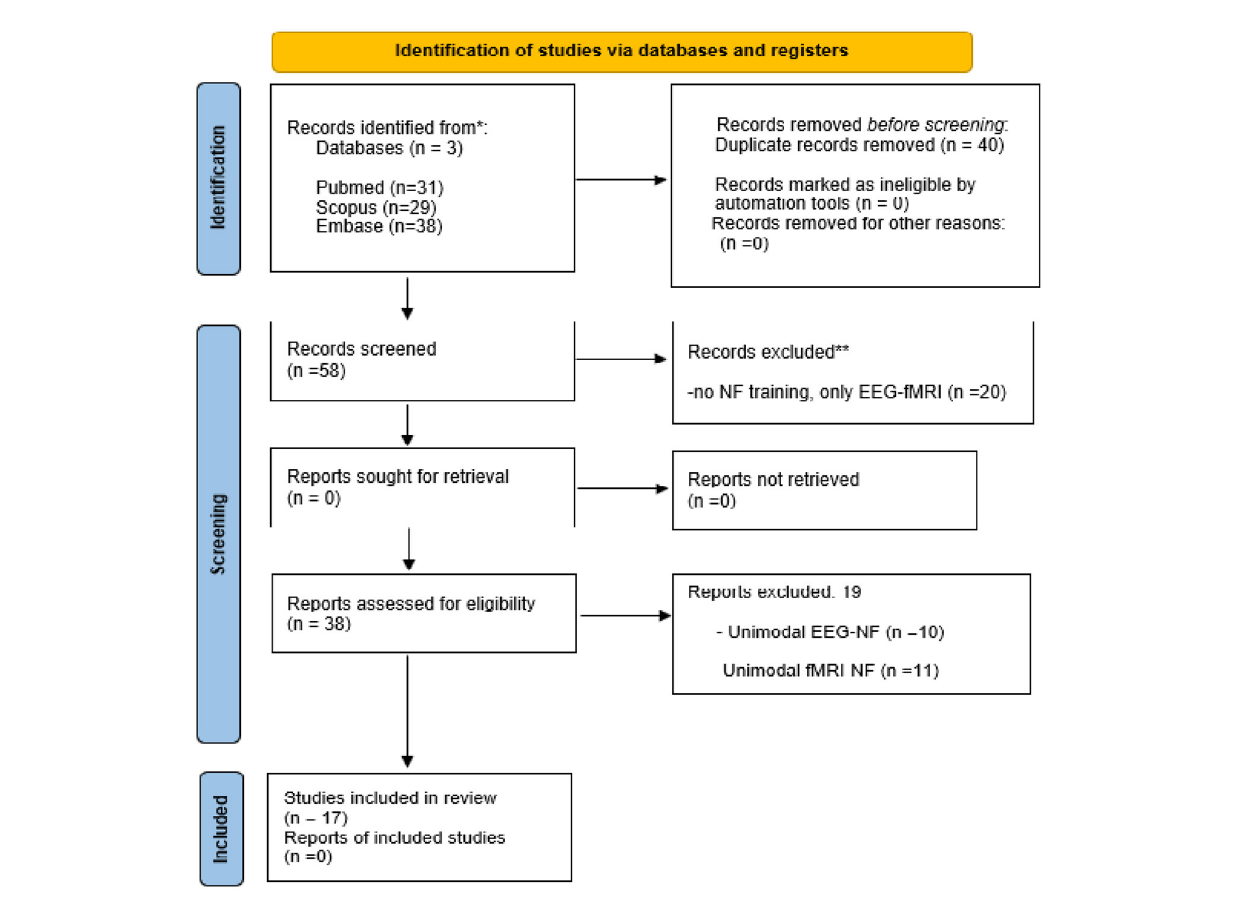
FIGURE1 PRISMA study selection diagram. The diagram moves through the four stages of PRISMA study selection: identification screening, screening, eligibility and included. From an original count of 98 studies, 17 were finally selected for this review. NF, neurofeedback; EEG, electroencephalograph; fMRI, functional magnetic resonance